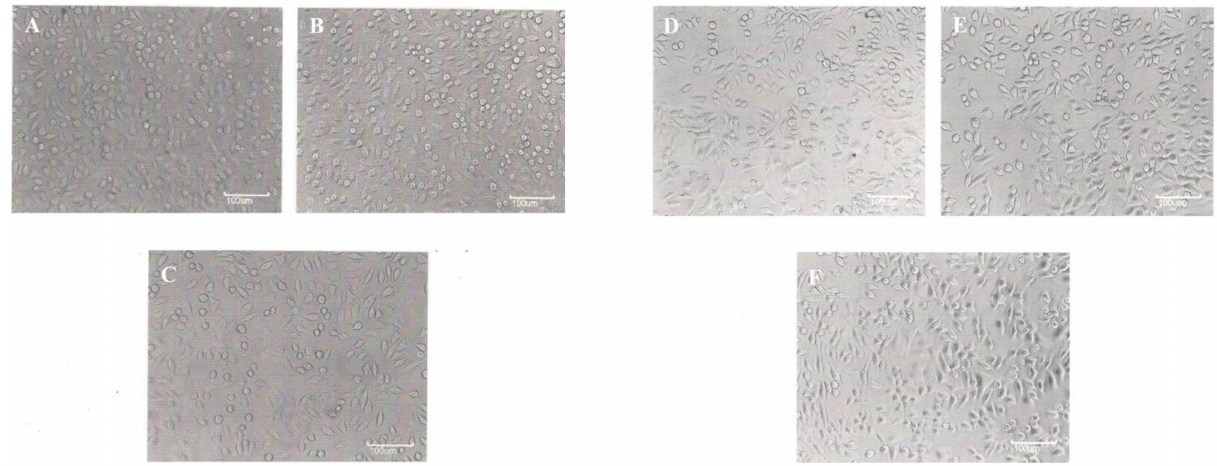
Figure 7. Microscopic image of L-929 cells exposed to different proportions (100%, 50% and 25%) of extract media of ( A – C ) non-coated SS 420A ( D – F ) coated SS 420.